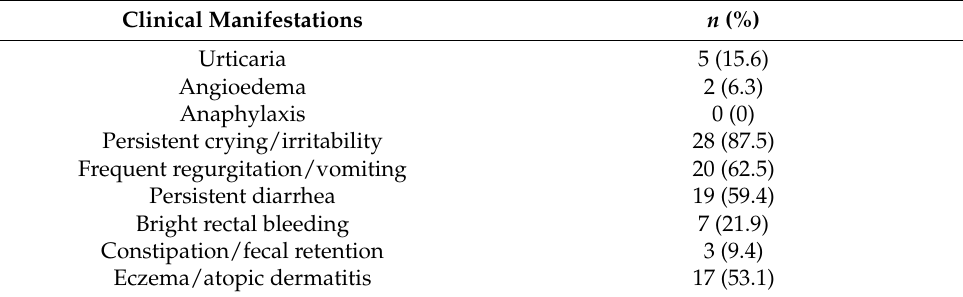
Table 2. Clinical manifestations of CMPA at enrollment ( n =